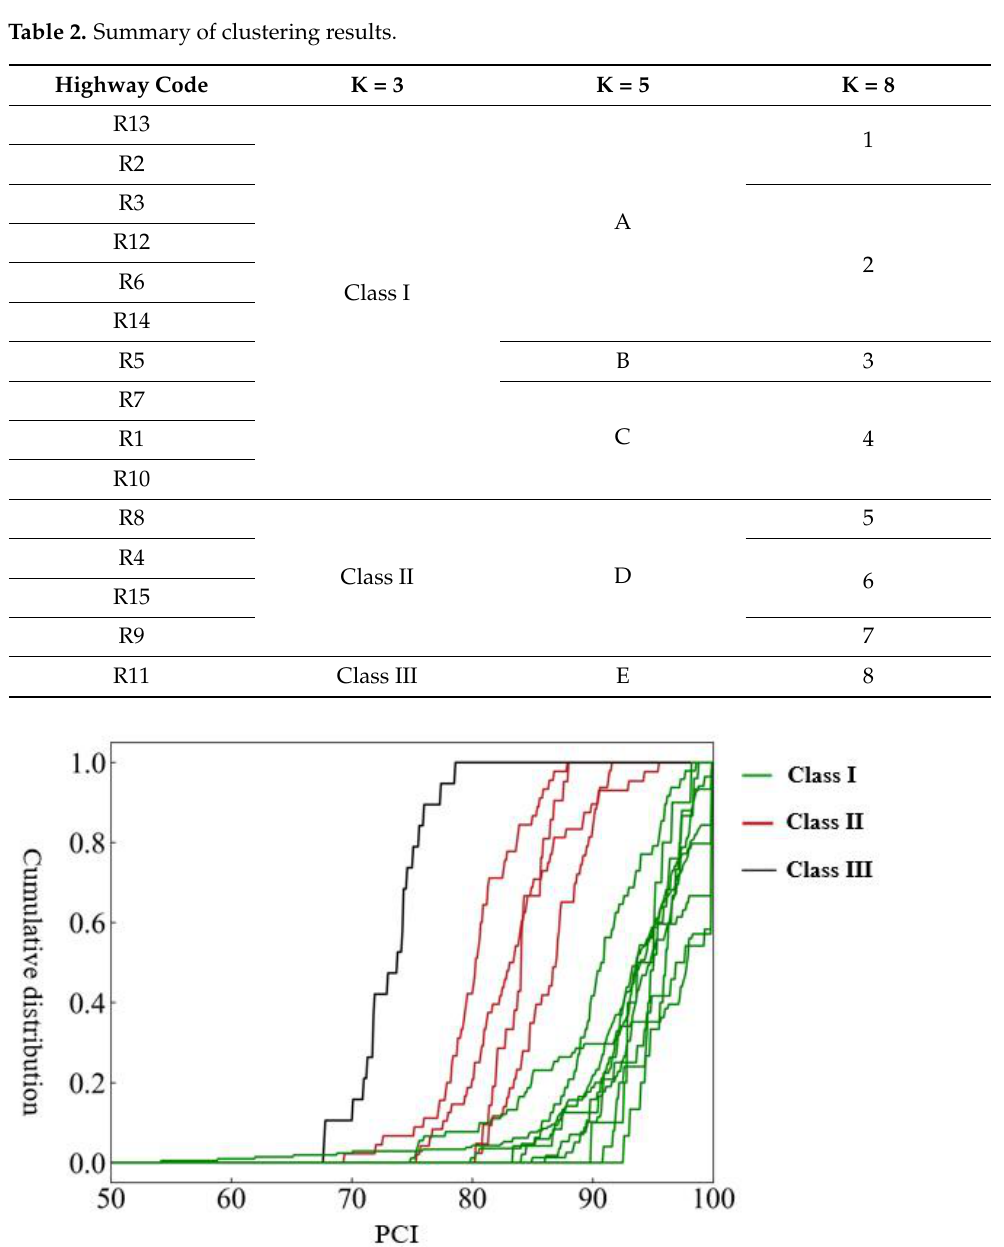
Figure 3. Clustering diagram obtained by using K-means algorithm based on road performance distribution of road sections (K = 3).